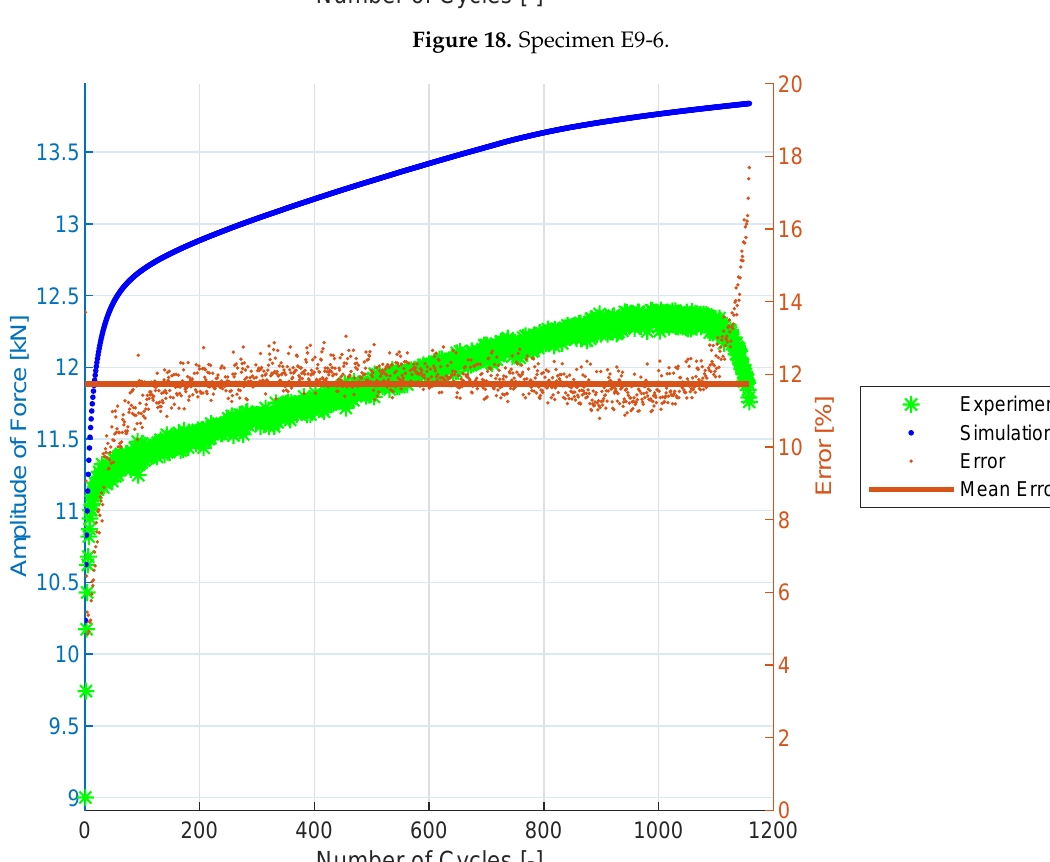
Figure 18. Specimen E9-6.